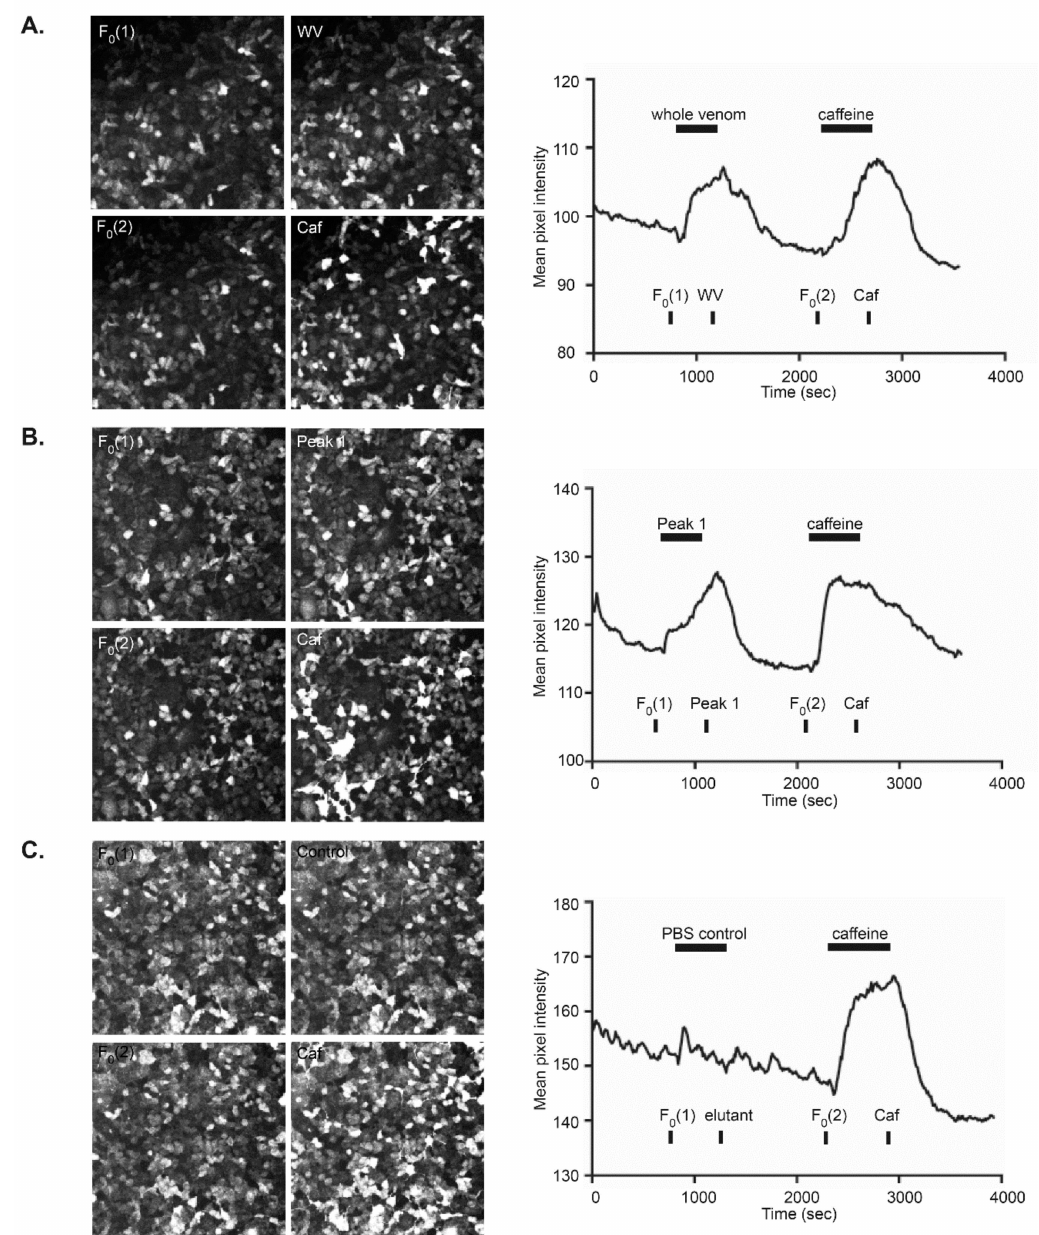
Figure 5. Examples of confocal fluorescence imaging of cytosolic Ca 2 + in GCaMP5G-RyR1-HEK293 cells with application of whole venom (WV), peak sample 1 (Peak 1), ca ff eine and a PBS control. ( A ) Application of whole venom from Australian scorpion Hormurus waigiensis was compared to 4 mM ca ff eine positive control. ( B ) SE-FPLC peak sample 1 response compared to ca ff eine control. ( C ) PBS control compared to the ca ff eine positive control. The graphs reflect the continuous imaging (10 s sampling), with mean pixel intensity representing the whole-of-field (512 × 512 pixels). F 0 (1) for quantitative analysis comprised an average of 3 frames (30 s); the image shown is frame 2 of this sample, 20 s prior to addition of venom. Similarly, the WV image is the second of 3 frames used for analysis just prior to washout with media. F 0 (2) was used as the background reference just prior to addition of ca ff eine as a positive